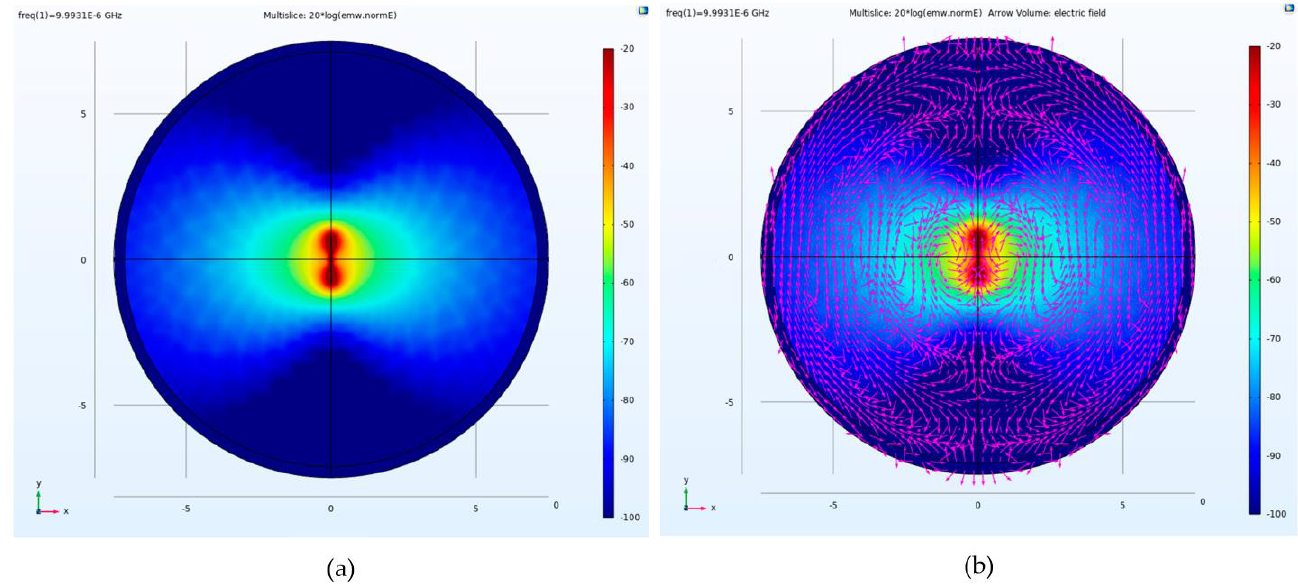
Figure 5. ( a ) Electric field distribution and ( b ) direction of dipole antenna.